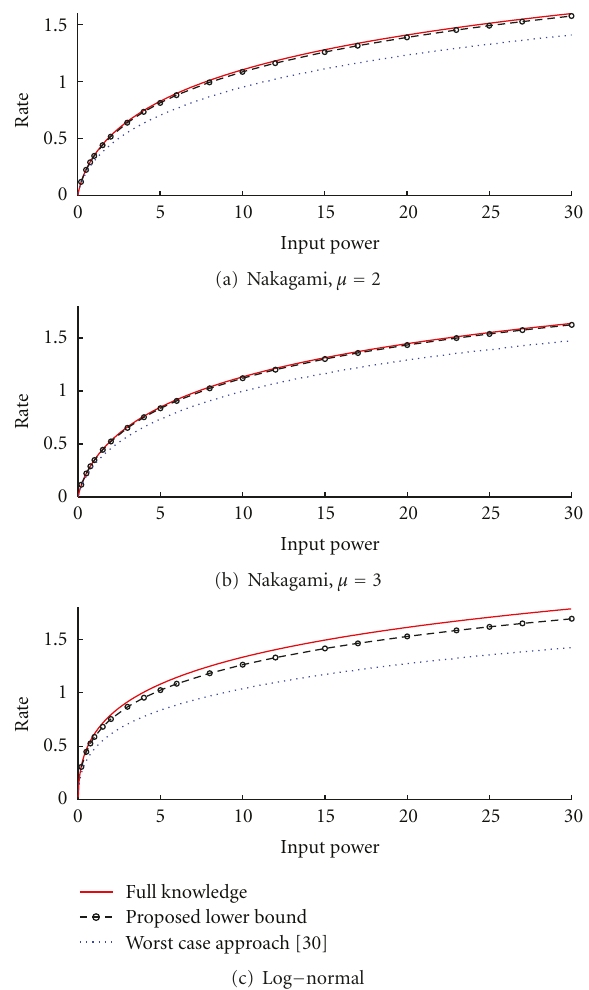
Figure 7: Comparison between the two proposed channel capacity lower bounds.